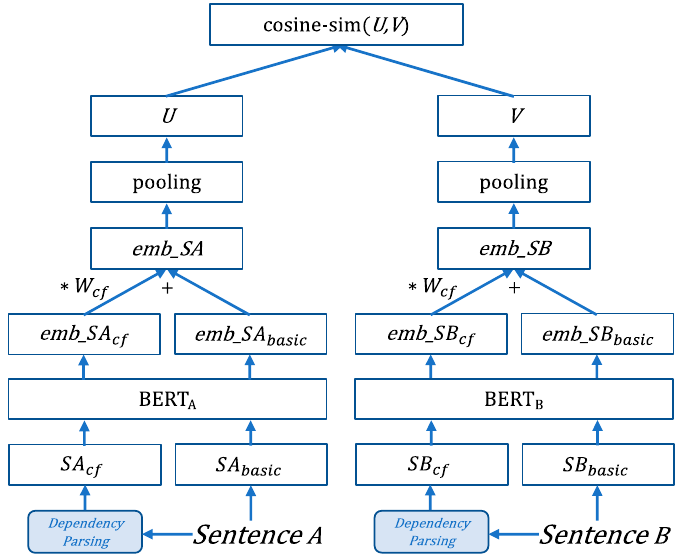
Figure 2. The overall architecture of the component focusing bidirectional encoder representations from transformers (CF-BERT) model (with semantic textual similarity tasks). The two BERT networks have tied weights (Siamese network structure).